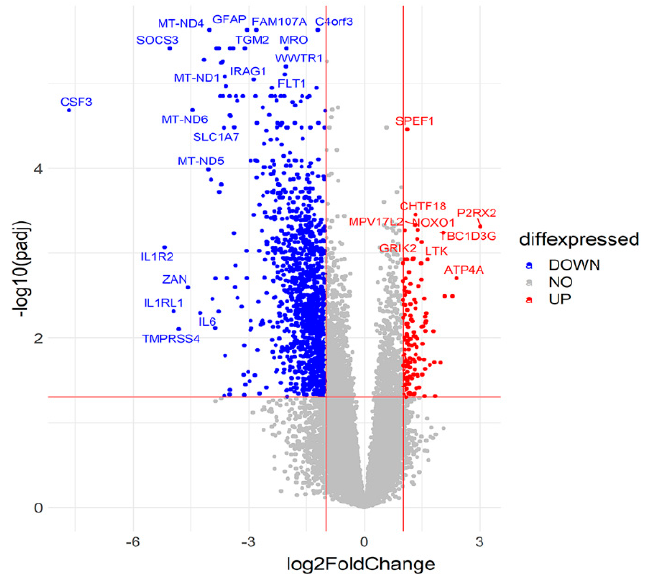
Figure 2. Visualization of RNA-seq results. Volcano plot showing the log2 fold change (log2FC) of gene expression and the statistical significance of the differential expression (DE) analysis performed between suicide and control individuals. The x-axis represents the log2 fold change of genes, while the y-axis represents the − log10 of the corrected p -values (padj) for the different pairs of conditions. Each dot represents a gene and the colored areas represent the DEGs that met the following selection criteria: log2FC of at least ± 1 (log2FC ≥ 1 or ≤− 1) and Benjamini and Hochberg-adjusted p -value < 0.05. Upregulated genes are shown in red, while the downregulated ones are blue. The top 40 significant DEGs are labeled.